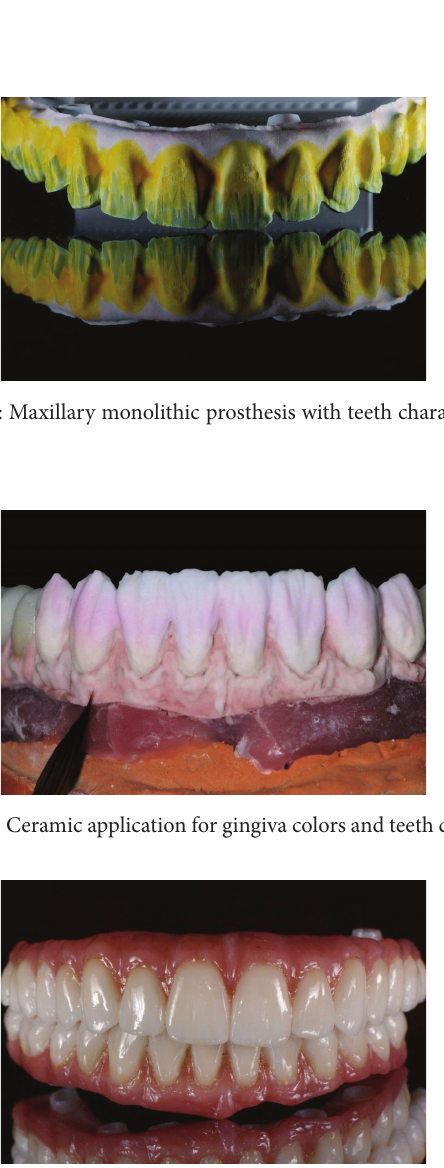
Figure 8: Prostheses after final sintering.